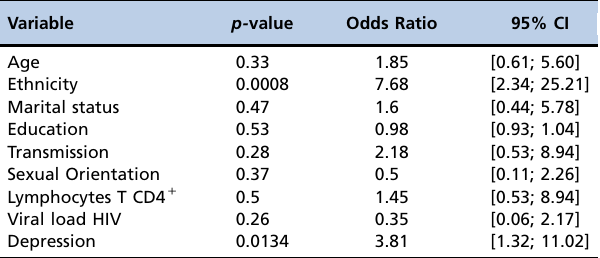
Figure 1 - The diagnosis of the logistic regression model. Since all residues are within the confidence band of the expected distribution, the model is well adjusted. Table 5 - Demonstration of the multivariate analysis regarding adherence as a response variable related to the other variables studied.